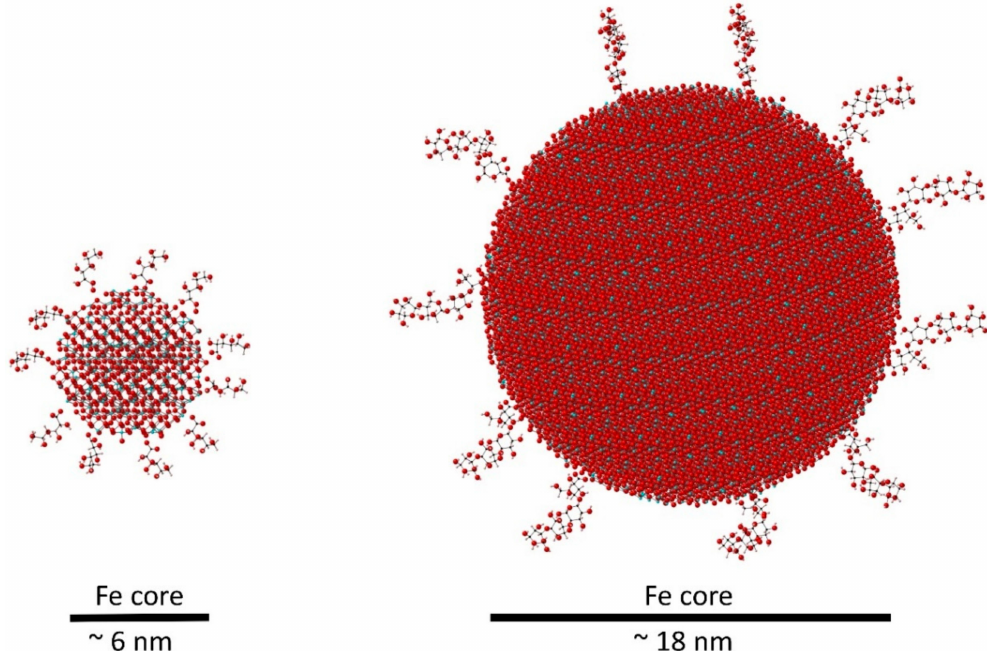
Figure 2. Schematic illustration of the relative size and composition of iron gluconate (left, low molecular weight, 37,500 Da) and iron carboxymaltose (right, high molecular weight, 150,000 Da). The models show iron-oxide cores, based on the neutron diffraction-derived structure of ferrihydrite [40], surrounded by the relevant organic ligands. Oxygen is shown in red, hydrogen in pink, carbon in black and iron in